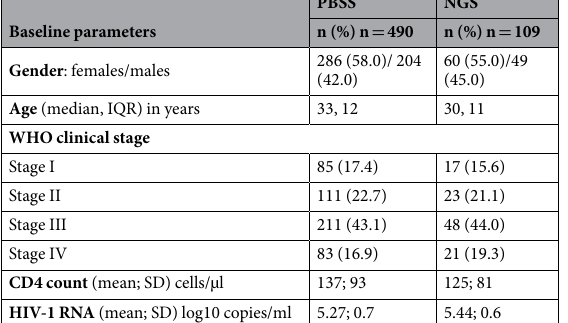
Table 1. Baseline sociodemographic, clinical and laboratory parameters of HIV-1 infected patients analysed with genotypic resistance testing. PBSS: population-based Sanger sequencing; NGS: next generation sequencing.